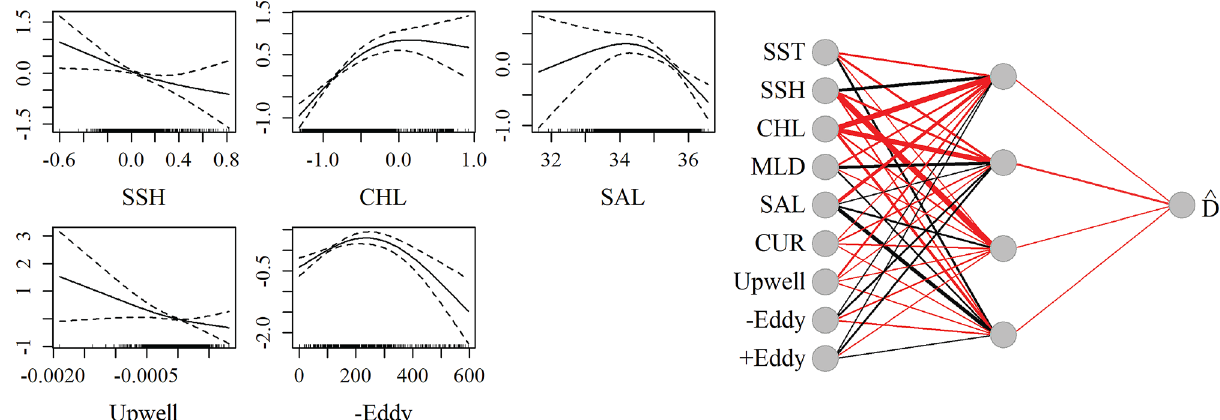
Figure 6. Influence of predictor variables in the best fitting sperm whale density models. Left : Smooths of significant terms in the joint GAM. Right : Neural network for sperm whale joint density model. Annotations as in Fig. 3.